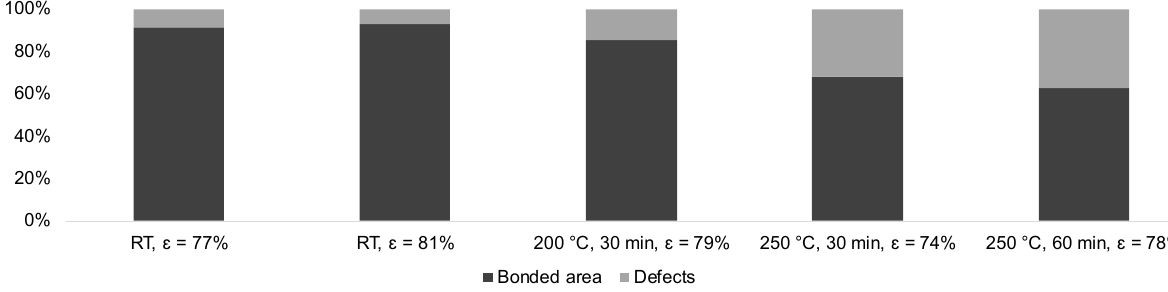
Figure 6. Image of the FIBed section from the sample treated at 250 °C for 30 min ( a ) and corresponding line scans ( b , c ).